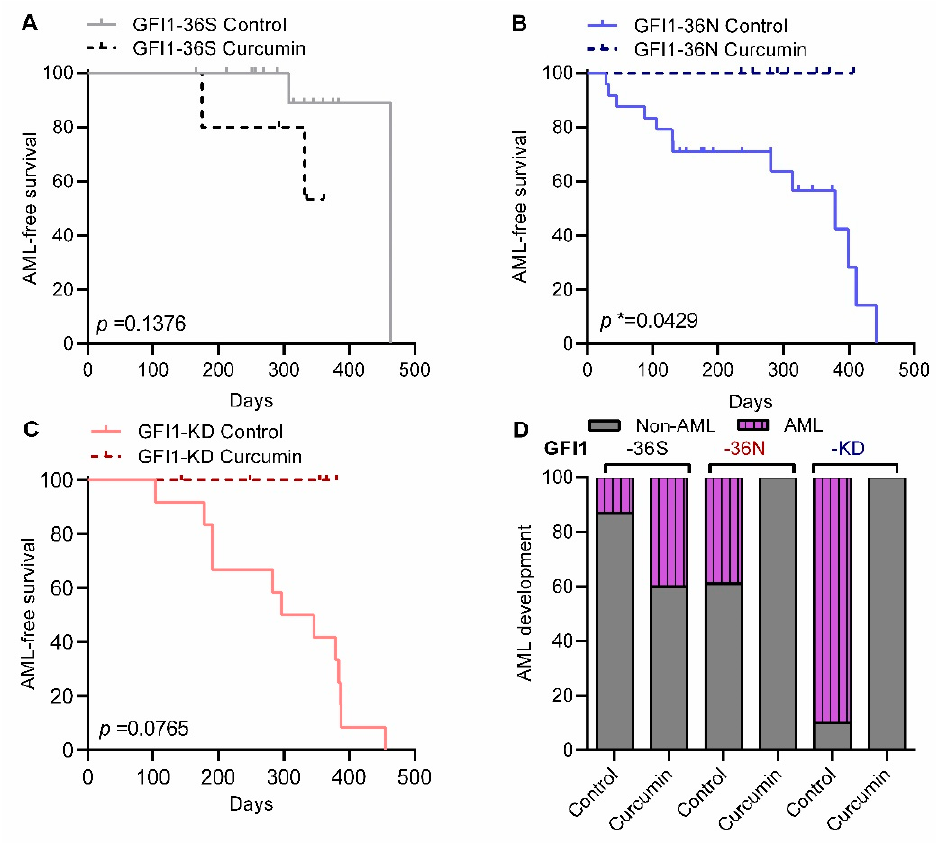
Figure 1. Effect of curcumin on AML free survival of GFI1-36S/ -36N/-KD , NUP98/HOXD13 - tg mice. ( A – C ). Overview of the AML-free survival in GFI1-36S ( A ), GFI1-36N ( B ) and GFI1-KD ( C ) mice treated with curcumin or vehicle. ( D ). Quantification of AML development in vehicle or curcumin- treated GFI1-36S , -36N and -KD, GFI1-36S/ -36N/-KD , NUP98/HOXD13 - tg mice. * p < 0.05 .